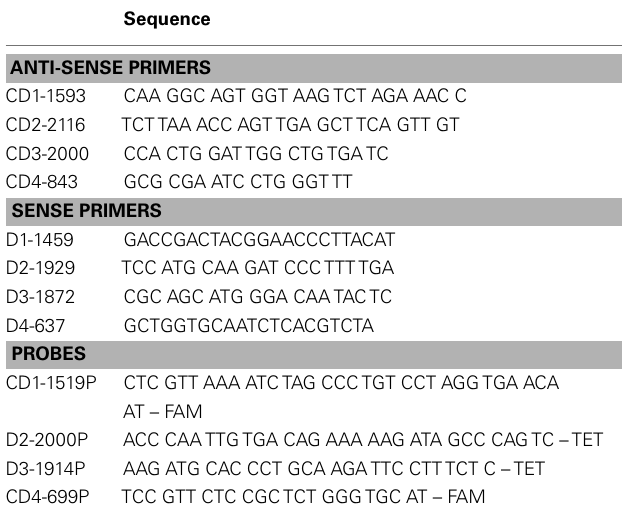
Table 1 | E protein primers used in this study